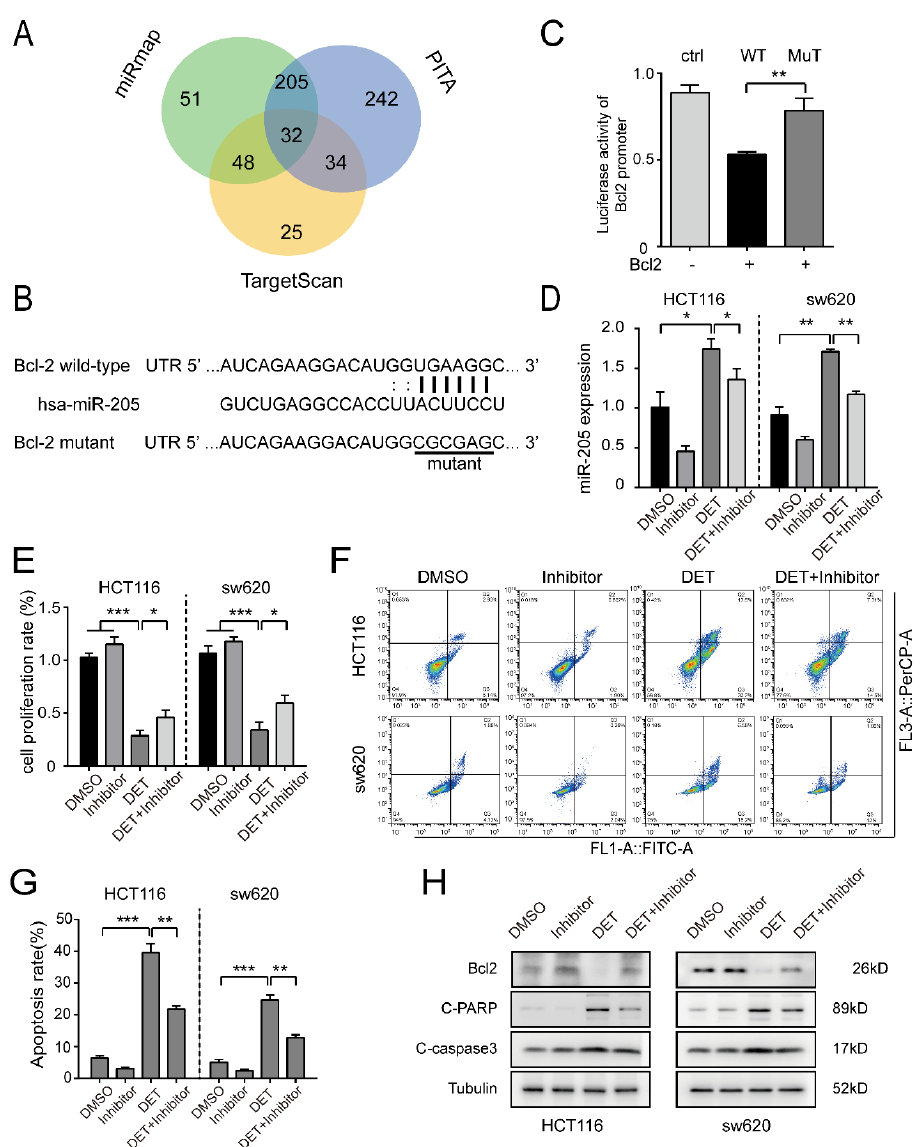
Figure 5. miR-205 is directly targeted by Bcl2 and induces the apoptosis of colon cancer cells. ( A ) Venn diagram showing the potential miR-205 targets predicted by databases. ( B ). The putative binding site of miR-205 and Bcl2 is shown. A schematic of the construction of wild-type or mutant pGL3-Bcl2 3 ′ -UTR vectors is indicated. ( C ) The 293FT cells were co-transfected with miR-205 and wild-type or mutant Bcl2 3 ′ -UTR fused to the Renilla luciferase vector. The relative firefly luciferase activities were determined. ( D ) The expression of miR-205 after DET treatment or DET and the miR-205 inhibitor treatment for 48 h. ( E ) Cell proliferation of HCT116 and sw620 cells was promoted by the miR-205 inhibitor. ( F , G ) Flow cytometry assay showing that miR-205 inhibitor significantly reversed the apoptosis of cell metastasis in HCT116 and sw620 cells. ( H ) Western blot assays were used to detect the expression of proteins after treatment with the miR-205 inhibitor. All data were used as mean ± S.D., n = 3, significant difference was examined by Student’s t-test. * p < 0.05, ** p < 0.01, *** p < 0.001, versus control. Note: Inhibitor in this figure refers to the inhibitor of miR-205.